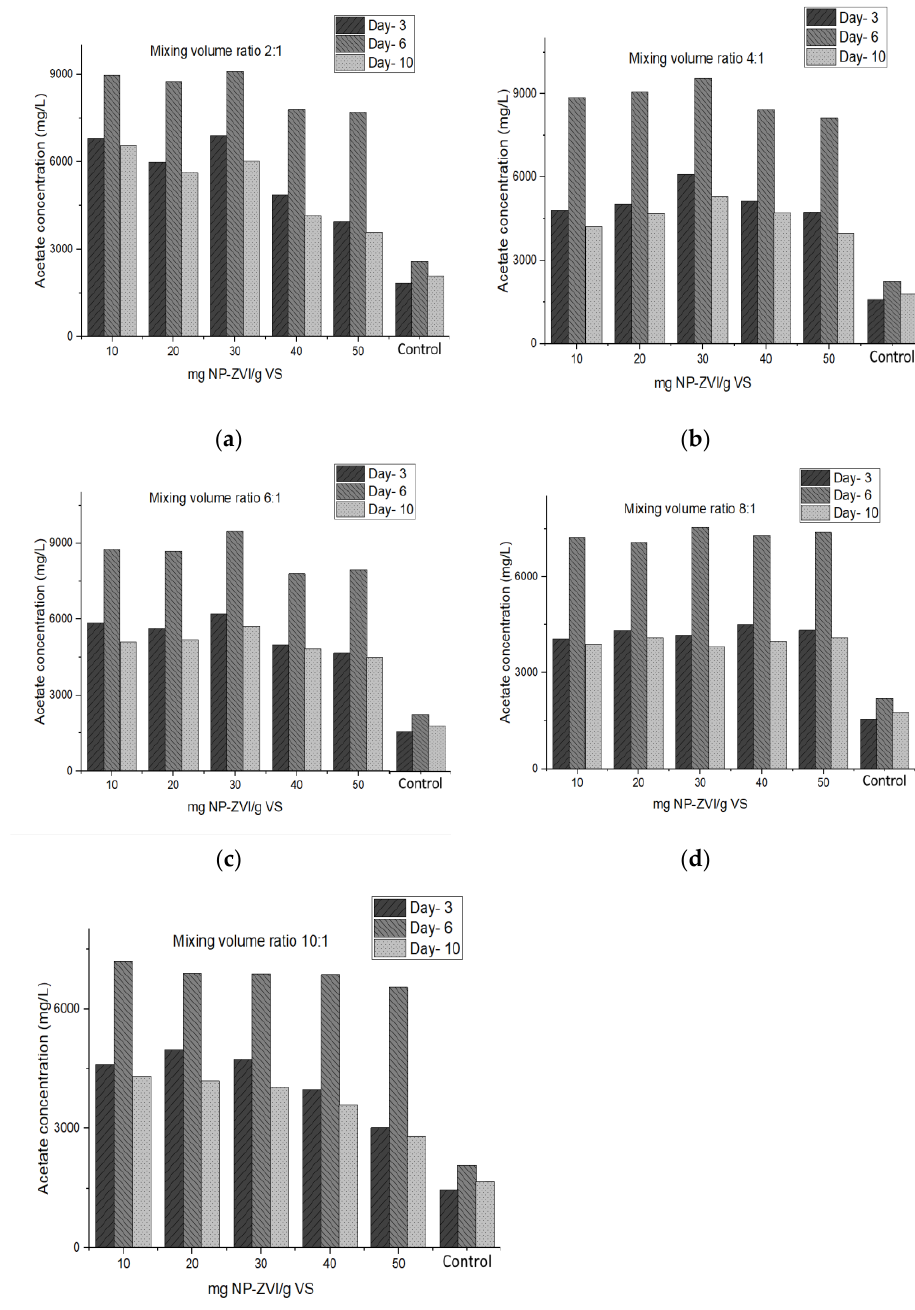
Figure 2. ( a ) Effect of different doses of NP-ZVI with MVR-2:1 on acetate concentration; ( b ) Effect of different doses of NP-ZVI with MVR-4:1 on acetate concentration; ( c ) Effect of different doses of NP-ZVI with MVR-6:1 on acetate concentration; ( d ) Effect of different doses of NP-ZVI with MVR-8:1 on acetate concentration; ( e ) Effect of different doses of NP-ZVI with MVR-10:1 on acetate concentration.